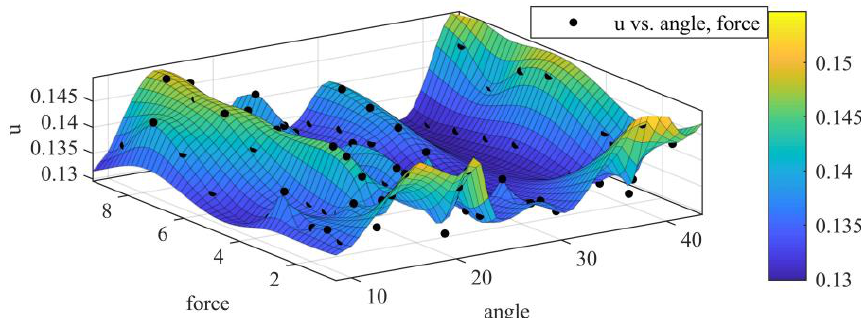
Figure 8. Fitted three-dimensional network of friction coefficient.